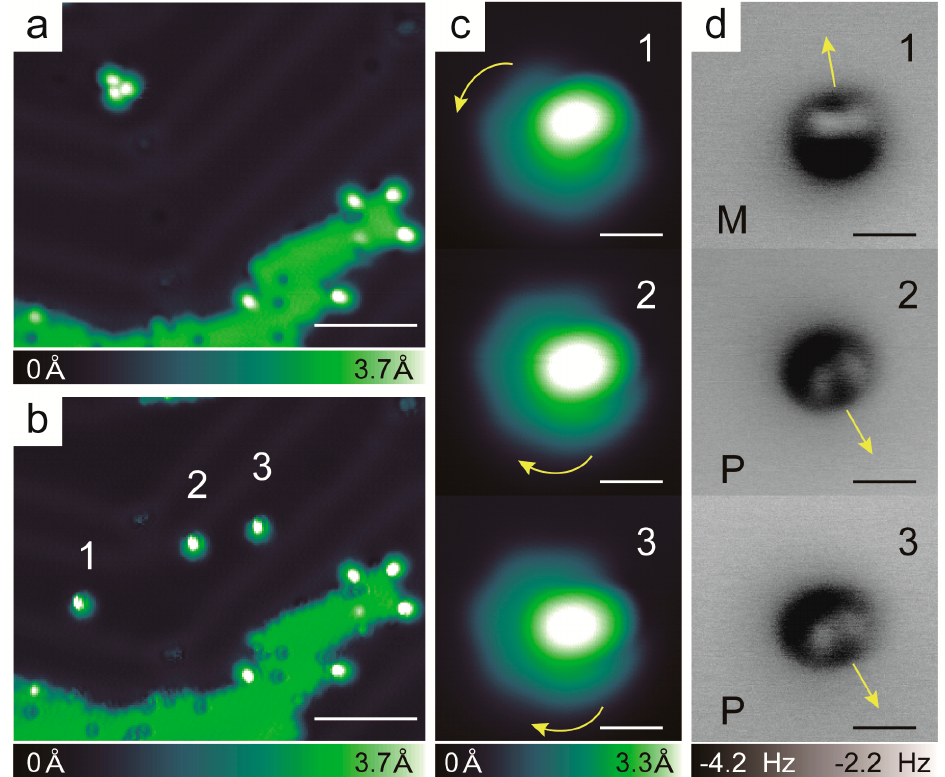
Figure 4. ( a , b ) Overview STM images before and after manual separation of the trimer (scale bars: 5 nm). The island in the overview image is a NaCl island, which was used to pick up the CO molecule for tip functionalization. ( c , d ) STM images, nc-AFM images of each helicene molecule manually separated from the trimer. Scale bars: 5 Å, CO tip. (300 mV, 10 pA for all STM images).